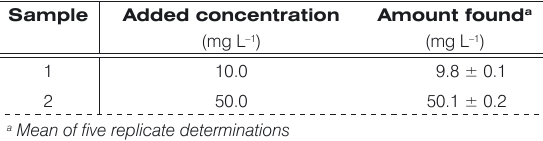
Table 3. Determination of PVK in spiked human urine